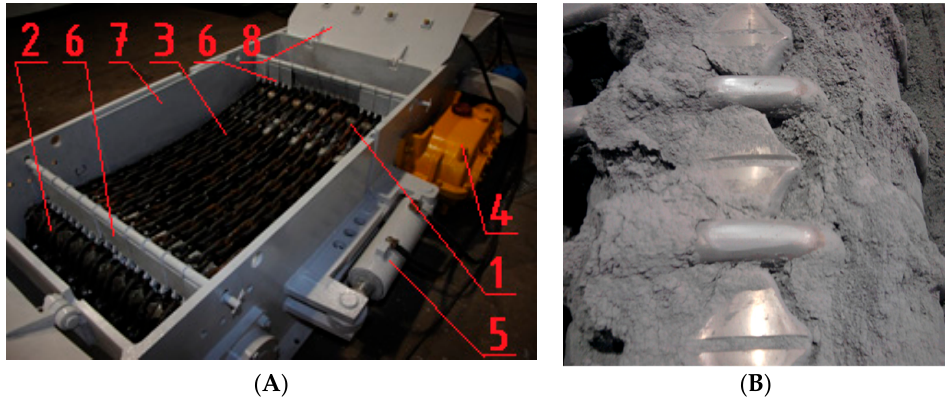
Figure 5. Test rig. ( A ) Rig (1—drive wheels, 2—turning wheels, 3—chains, 4—drive, 5—tensioner, 6—beaters, 7—main frame, 8—cover). ( B ) Testing chain drums filled with dry quartz abrasive.